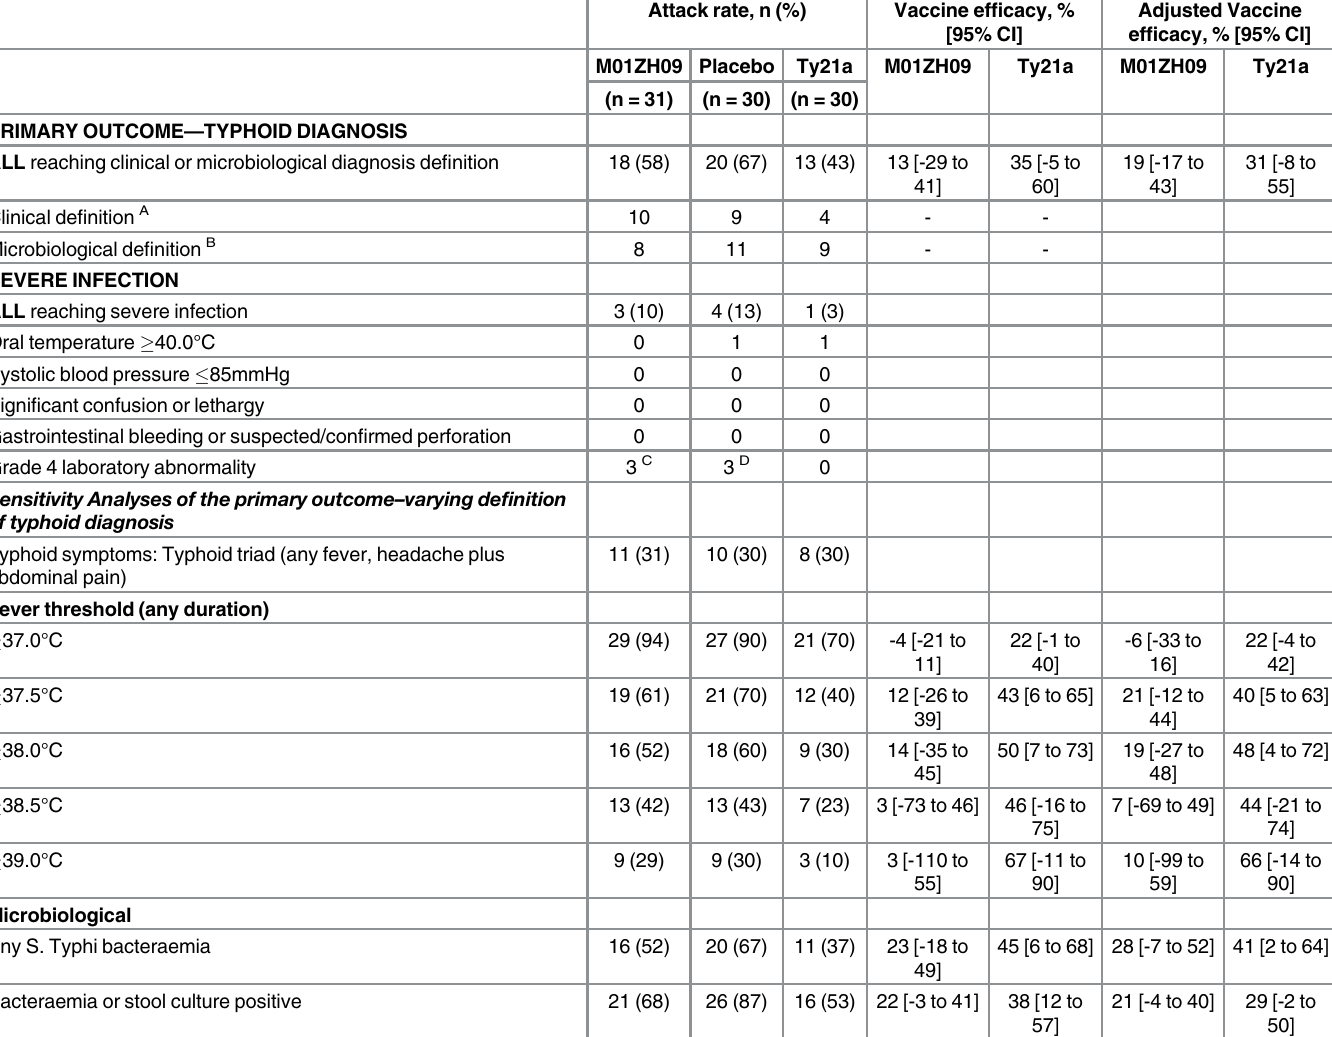
Table 2. Summary of vaccine efficacy endpoints and severity measures reached during the 14-day challenge